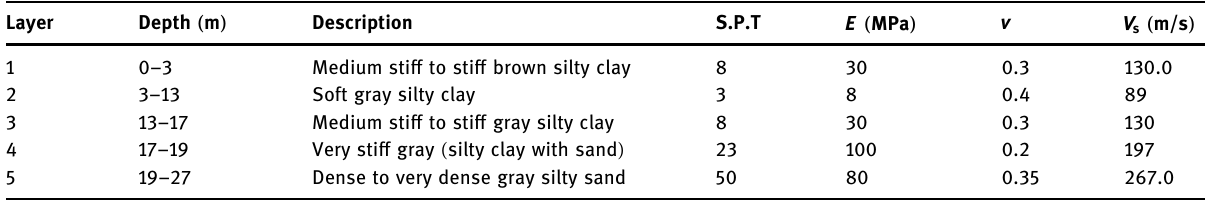
Table 2: Soil pro fi le characteristics at the study site